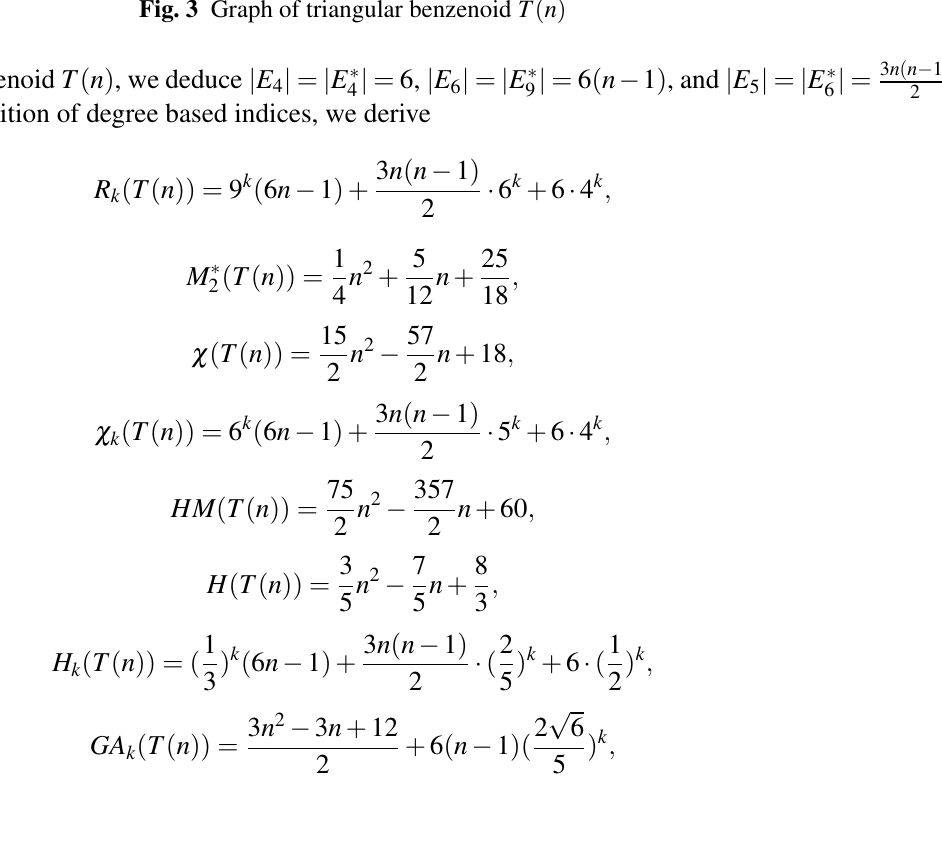
Fig. 3 Graph of triangular benzenoid T ( n